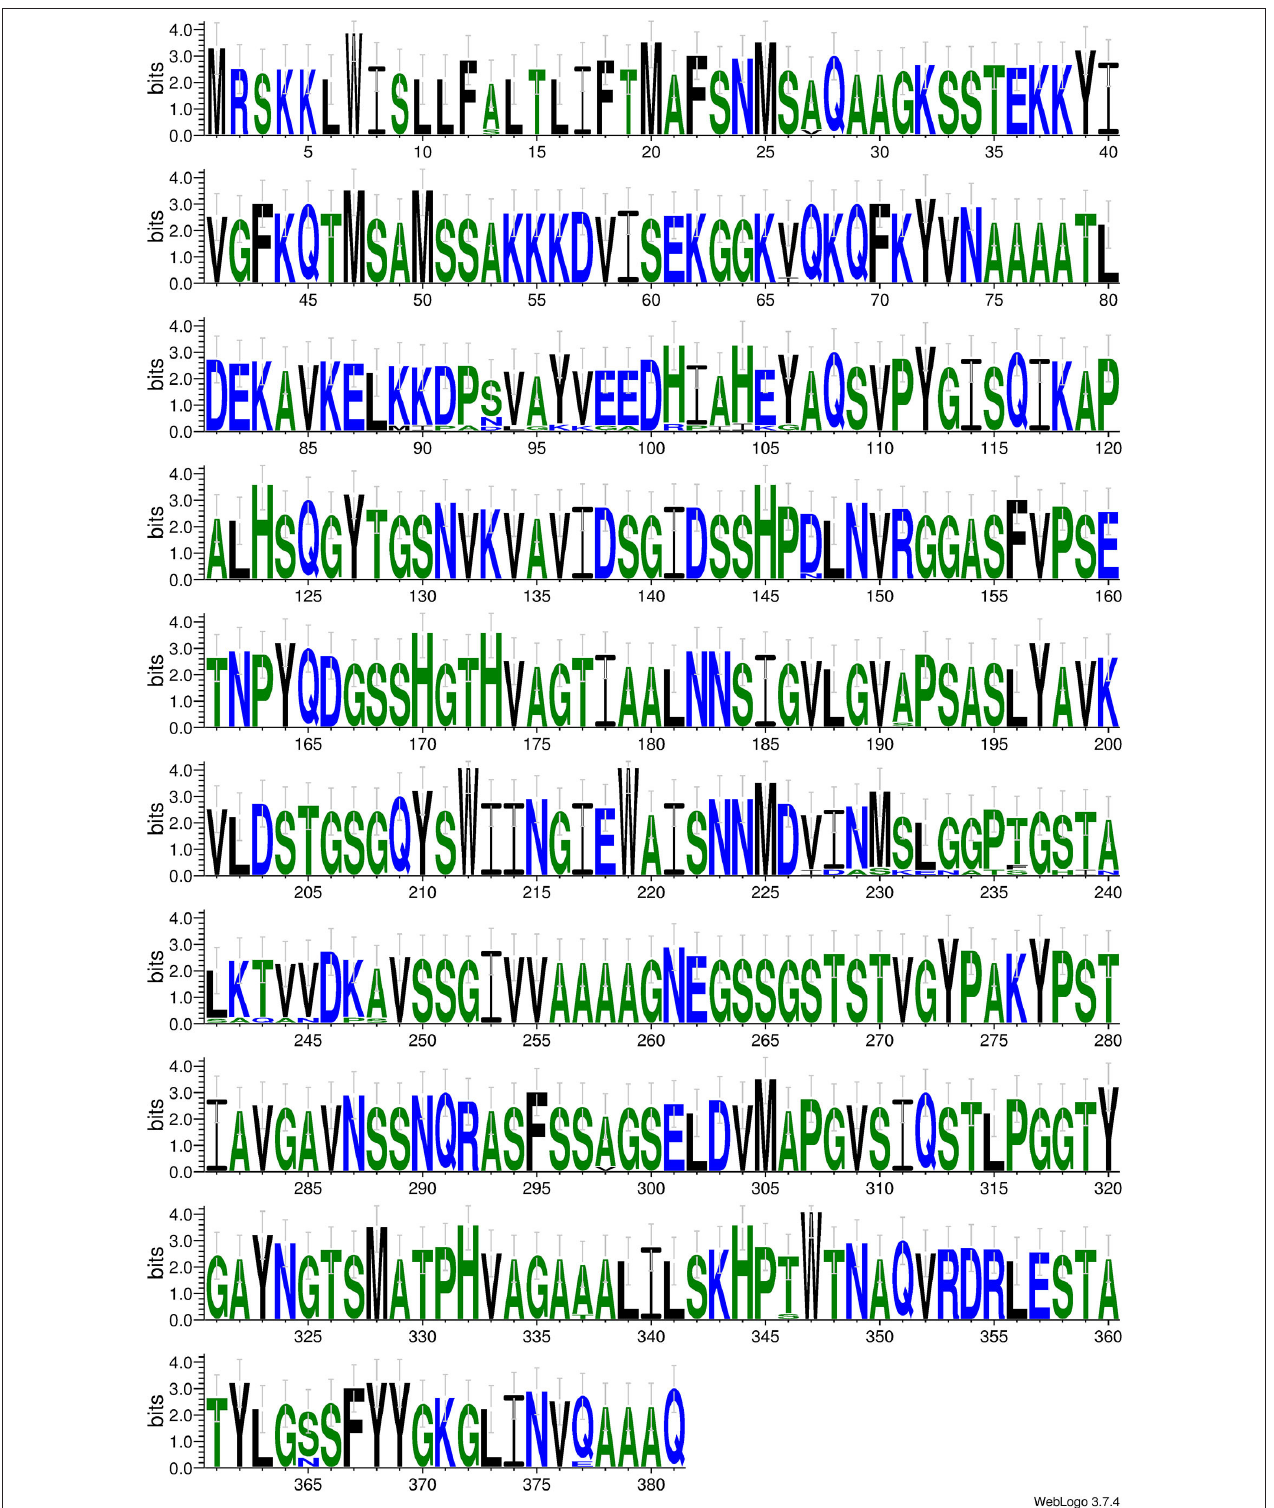
FIGURE 6 | Weblogo for conserved domain analysis of keratinase. Blue, green, and black colored are hydrophilic, neutral, and hydrophobic residues, respectively. The relative frequency of each residue is symbolized by height of symbol within stack and overall height of stack demarcates degree of conservation.